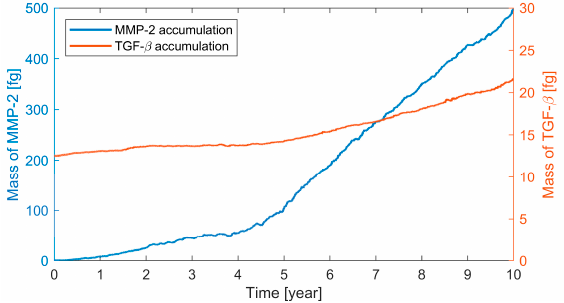
Figure 16. Accumulation of MMP-2 and TGF- β as a function of time of exposure to vibrations.